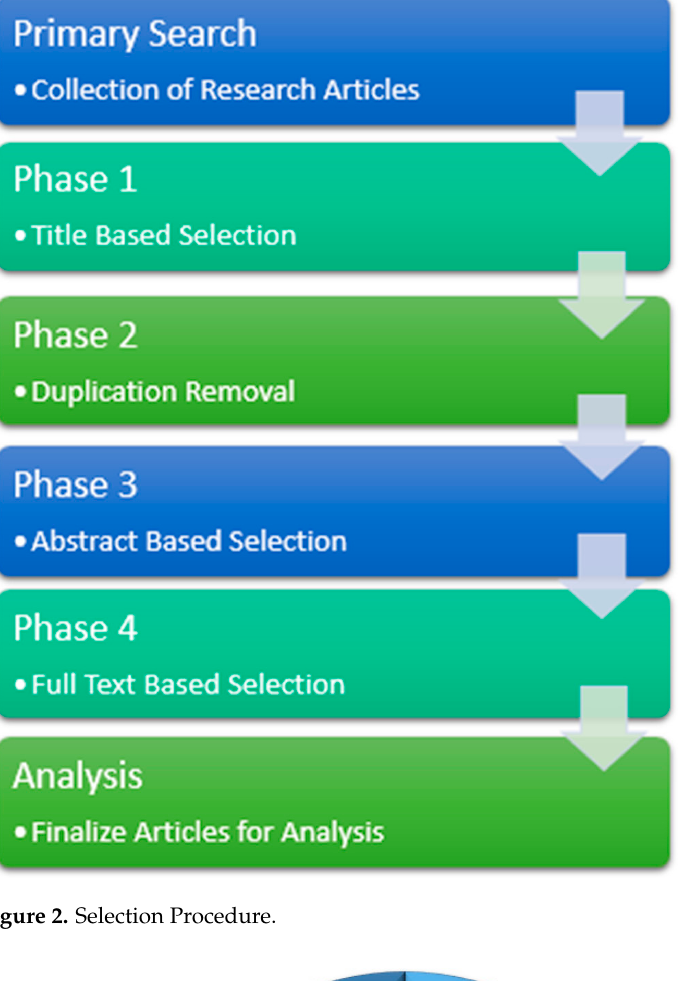
Figure 2. Selection Procedure.